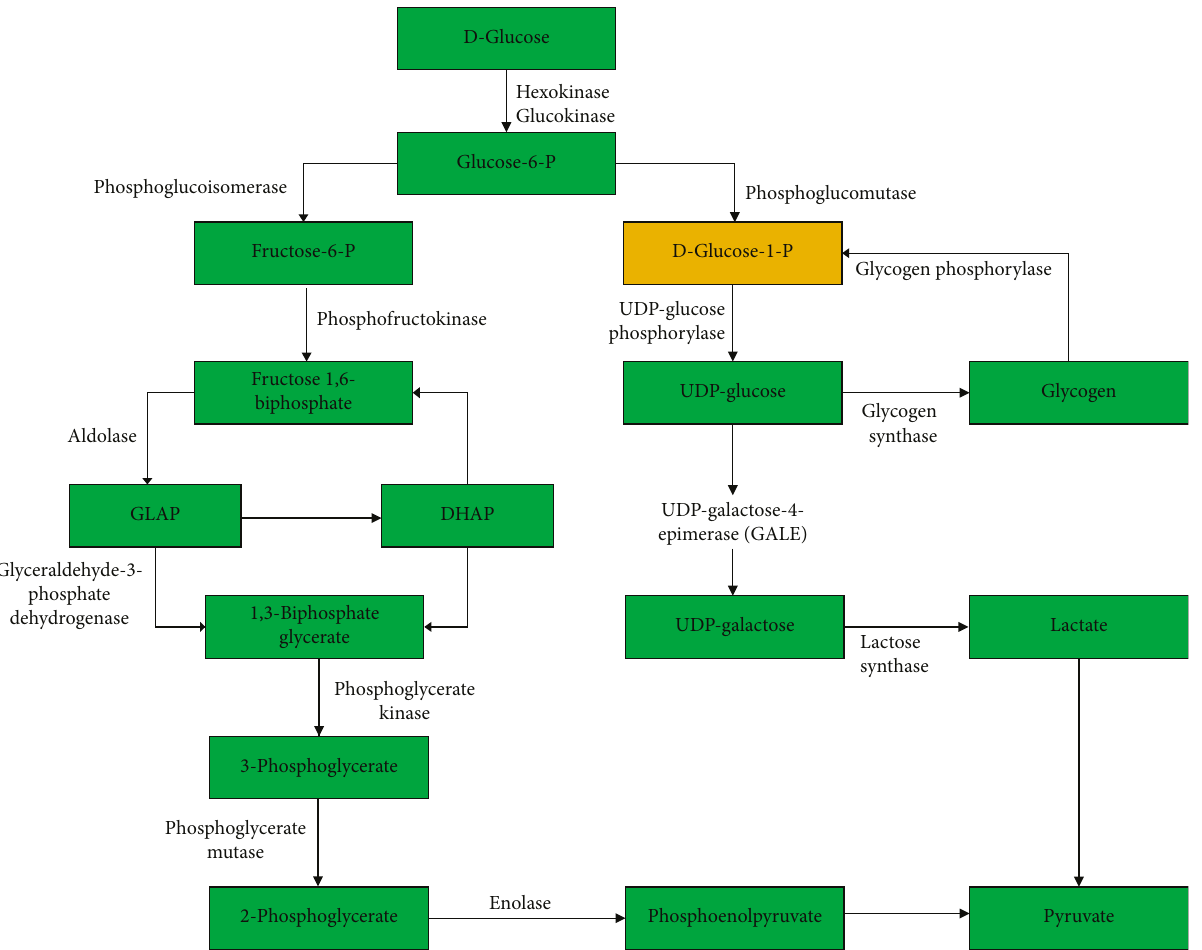
Figure 4: Predicted alternative metabolic paths in the glycolysis pathway. The compound (D-glucose-1-P) highlighted in gold represents the predicted alternative path to the fi nal product